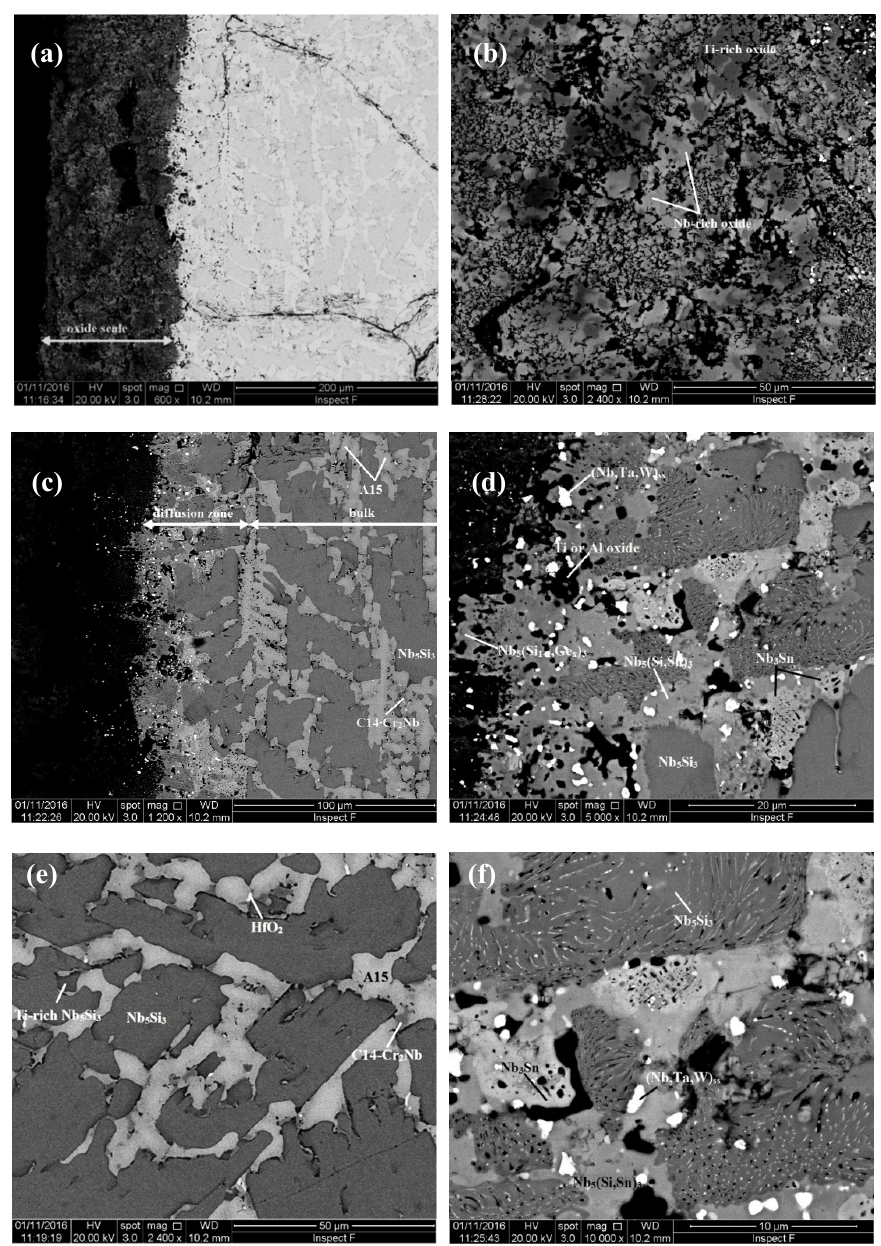
Figure 10. BSE images of the microstructure of a cross section of the oxidized alloy JZ3 at 1200 °C, ( a ) and ( b ) show the microstructure of the oxide scale, ( c ) diffusion zone and bulk, ( d ) micro-structure of the diffusion zone, ( e ) microstructure of the bulk and ( f ) white-line feature in the Nb 5 Si 3 (see text).